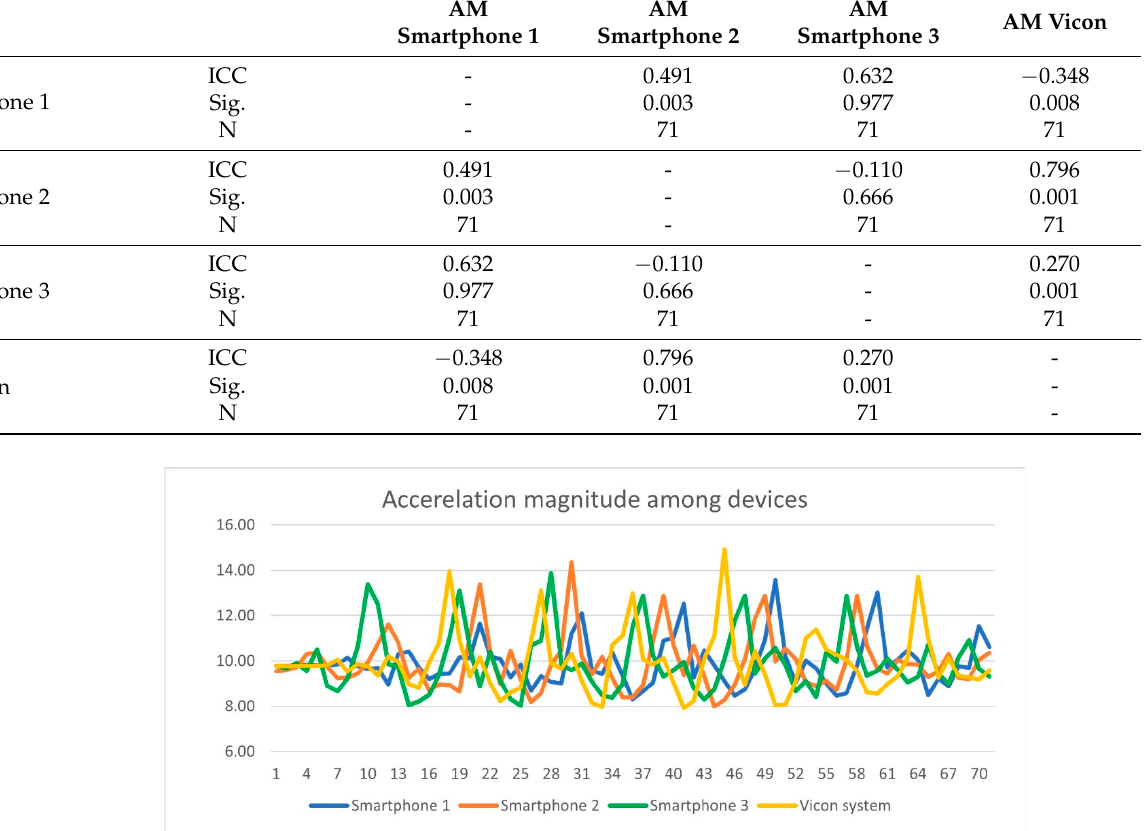
Table 6. Intraclass Correlation Coefficient values among device’s acceleration magnitude.